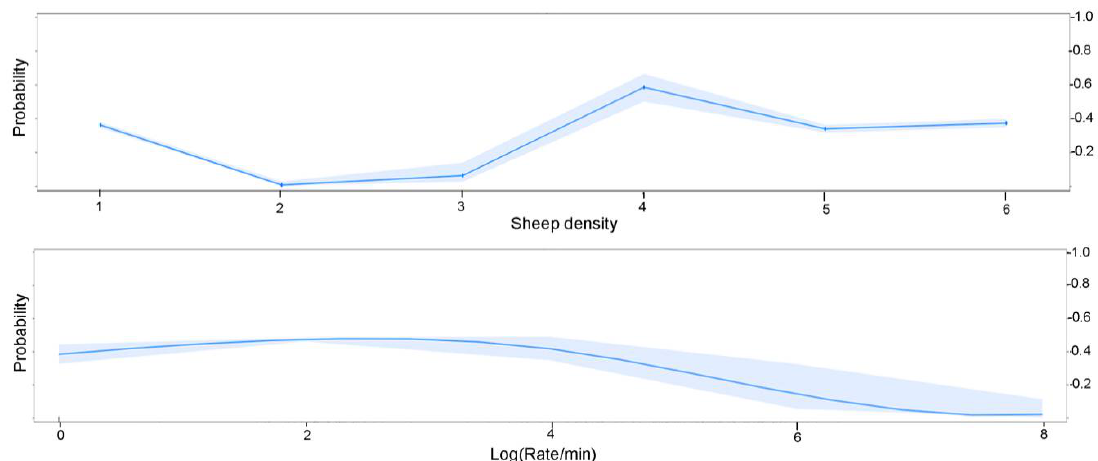
Figure 5. Probabilities extracted from the regression models showing the relationship between the probability of sheep distress behaviours being expressed and sheep density on the top and log (Rate/min) sheep movement speed on the bottom. Distress behaviour probability peaks at ‘moderate’ density and at moderate speed.